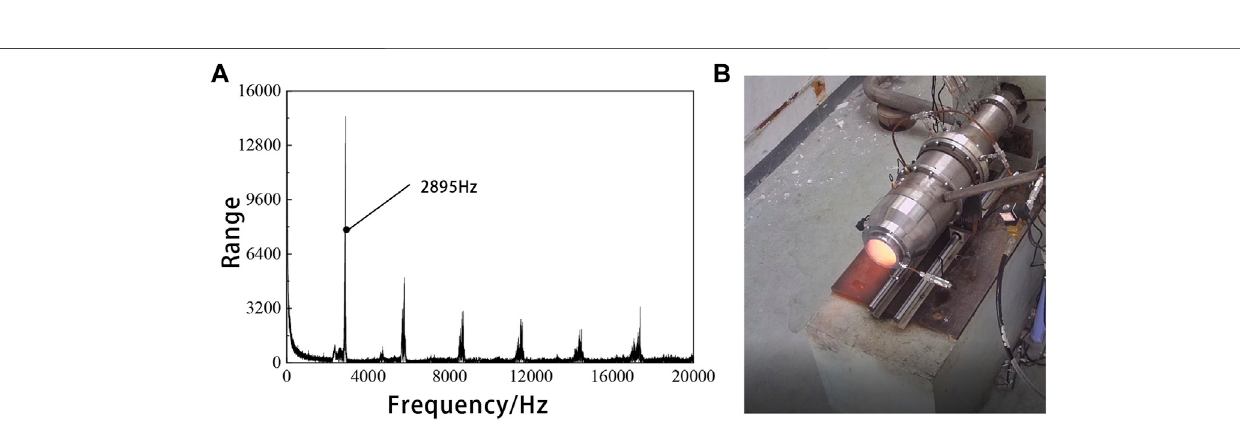
FIGURE 16 | Results of operating at T 0 (cid:1) 650K, _ m air (cid:1) 1 . 5kg/s, φ (cid:1) 1 . 152. (A) The FFT frequency distribution by P 1 ; (B) The Photograph of RDE.